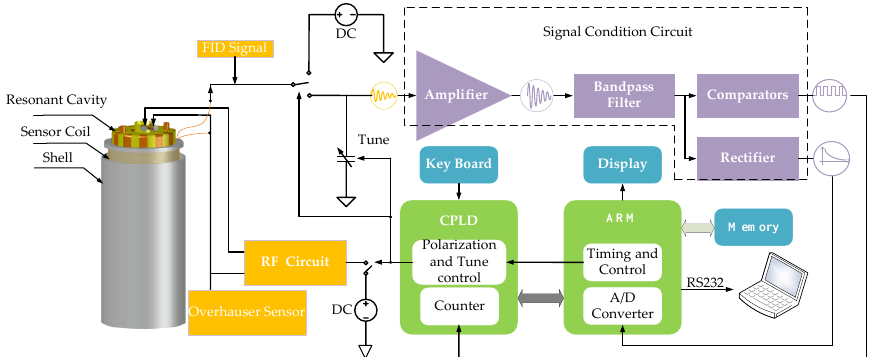
Figure 5. Block diagram of JOM-4S OVM.